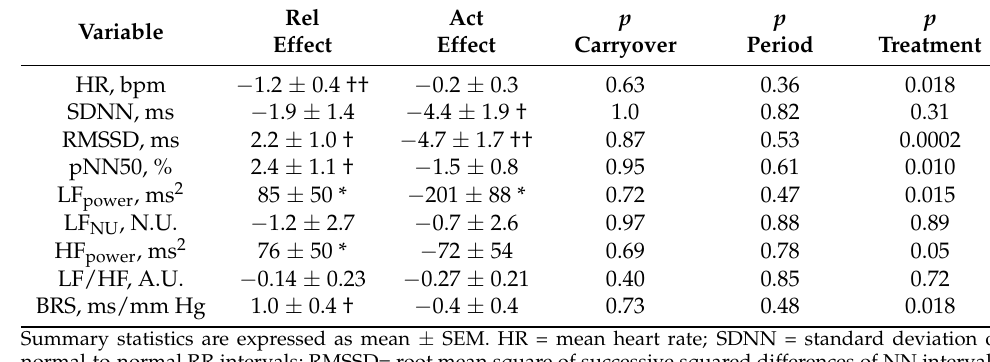
Table 2. Summary statistics of the difference between the value of heart rate and cardiovascular variability indices during stimulation and that during the preceding baseline condition (stimulation effect), with the significance probability of the tests for the carryover and period effects, and for the difference between the effects of the two